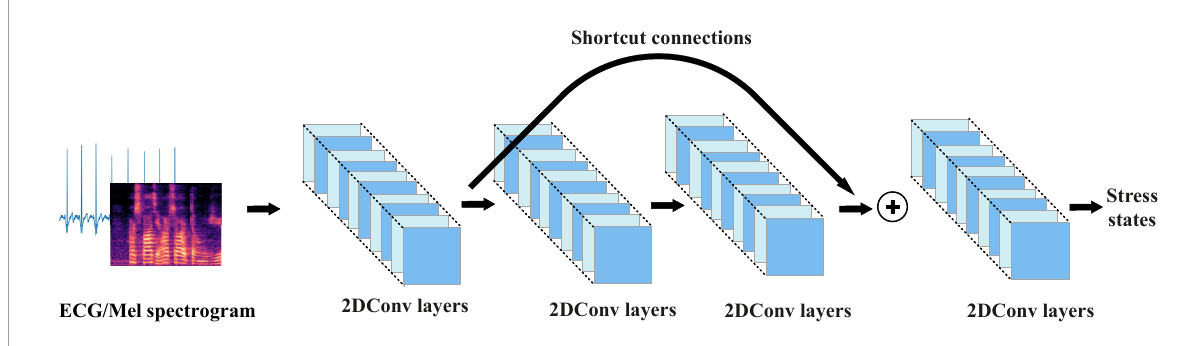
FIGURE5 2D convolution strategy for electrocardiogram and Mel spectrogram input in this